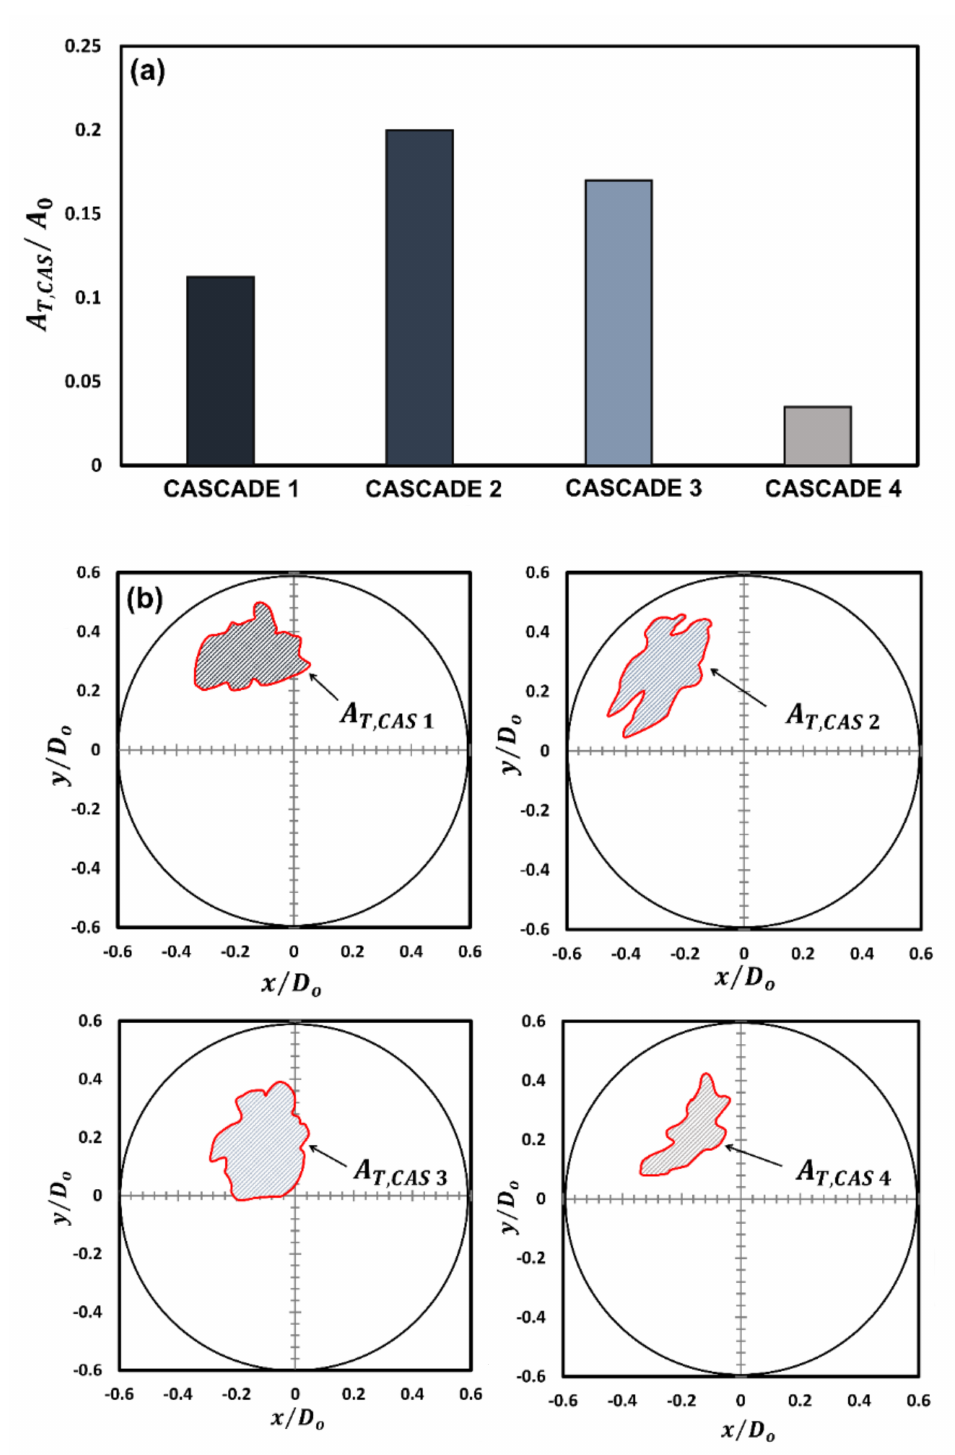
Figure 5. A comparison of the total rupture area for each cascade: ( a ) graphical representation and ( b ) schematic representation showing the area relative to the initial droplet